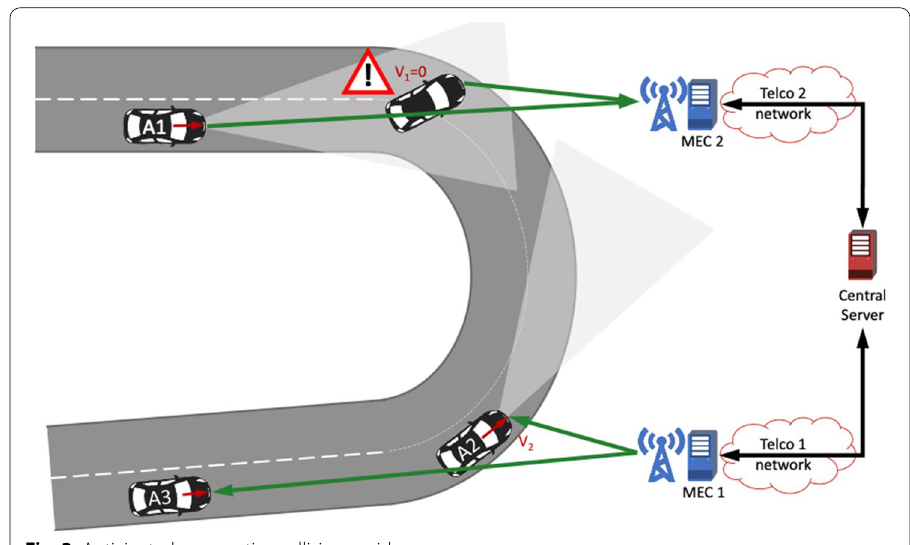
Fig. 3 Anticipated cooperative collision